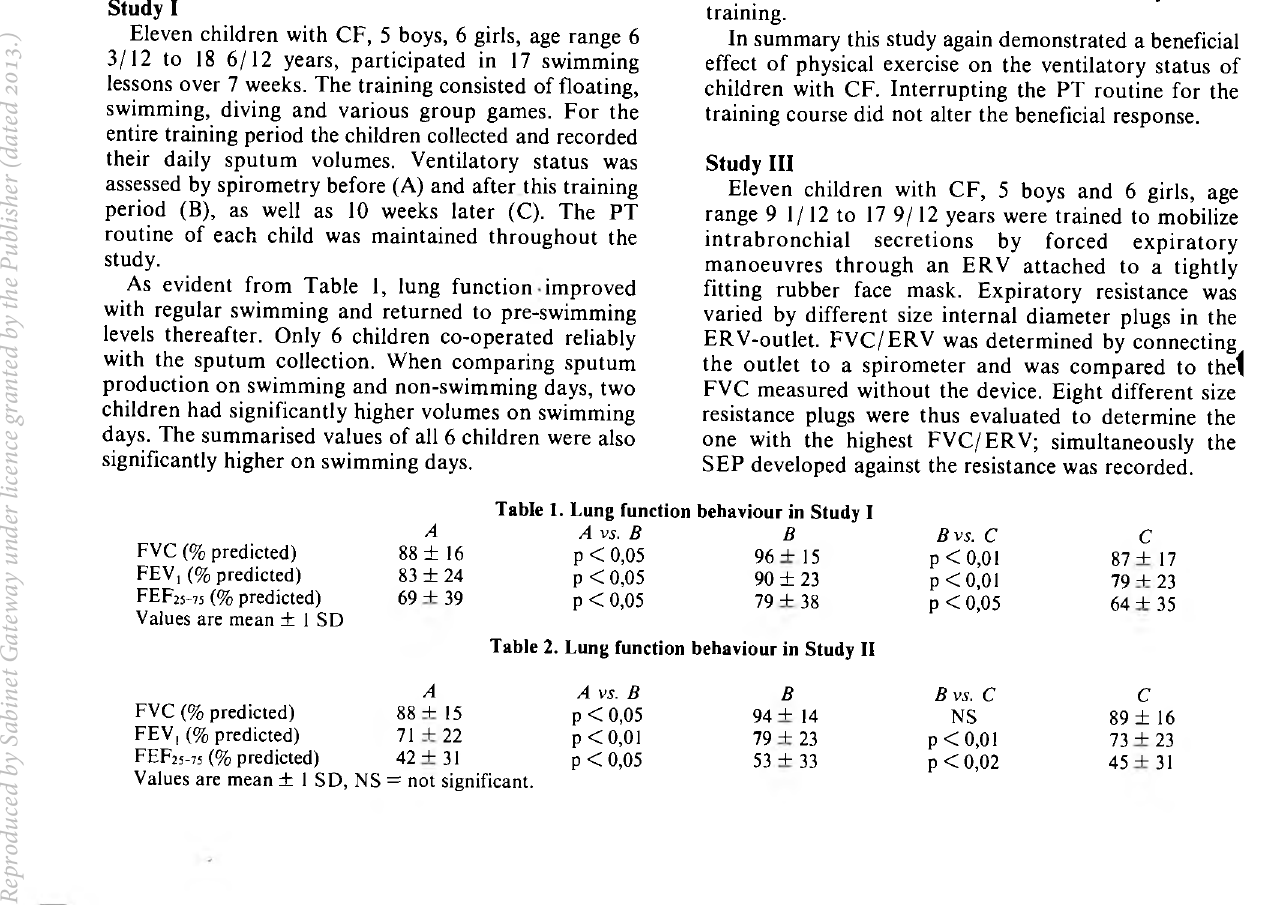
Table 2. Lung function behaviour in Study II